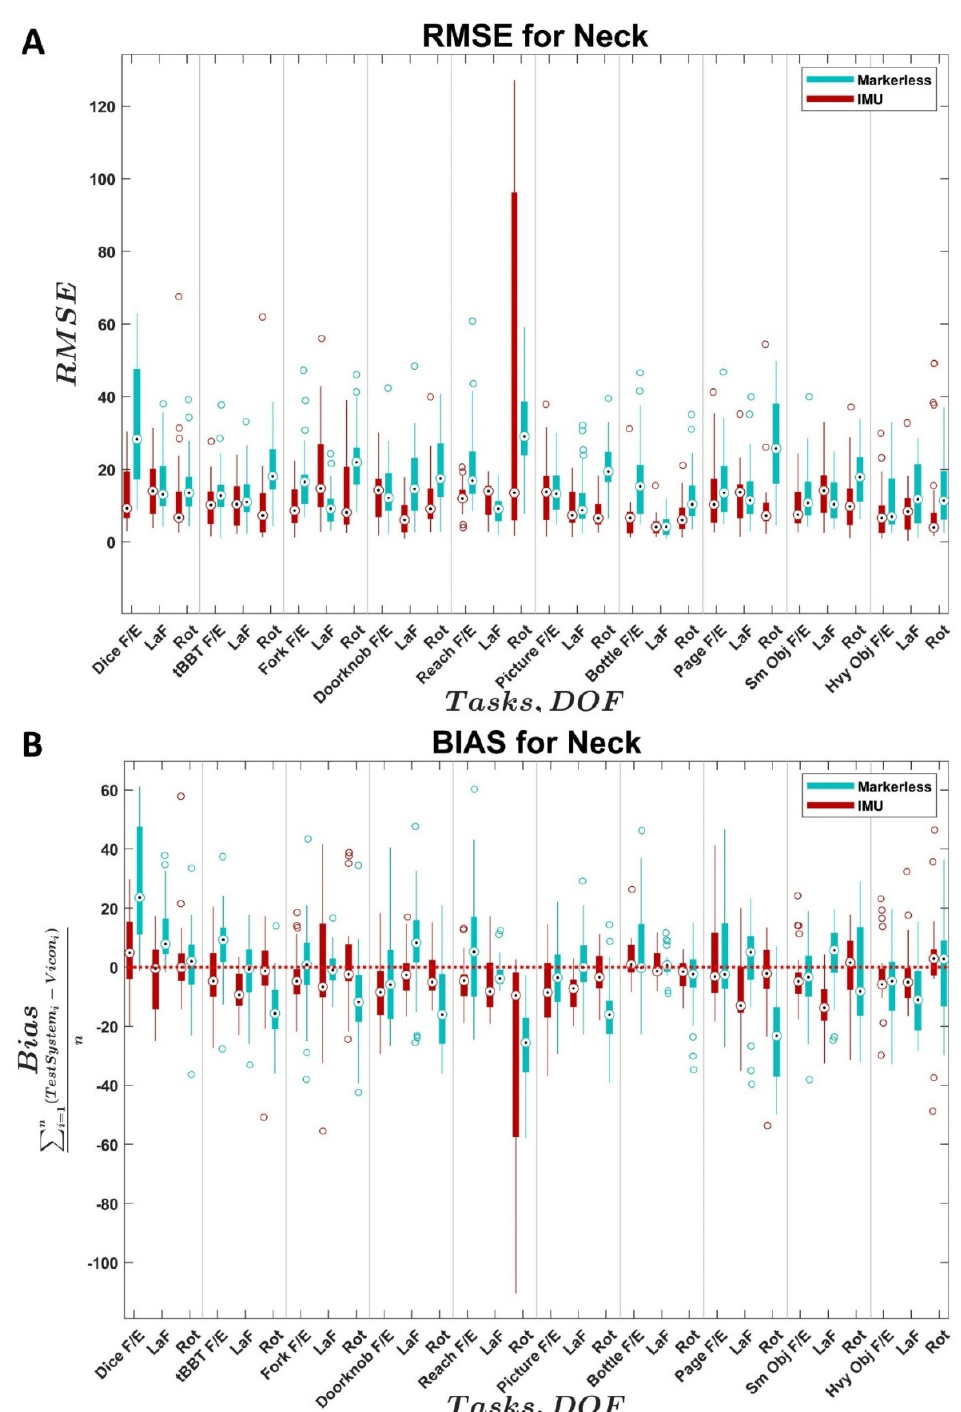
Figure 4. Distributions of ( A ) neck joint angle RMSE and ( B ) neck joint angle bias across subjects for the IMU system (Xsens Awinda MTw, El Segundo, CA) and markerless system (Kinect, Microsoft, Seattle, WA, USA) compared to the reference system (VICON, Oxford, UK). X-axis identifies the task and associated joint angle. F/E = flexion/extension, Ab/Ad = abduction/adduction, LaF = lateral flexion, Rot = rotation. Black dots indicate medians, empty circles indicate outliers, bold line indicates quartiles, and whiskers indicate non-outlier maximums and minimum.